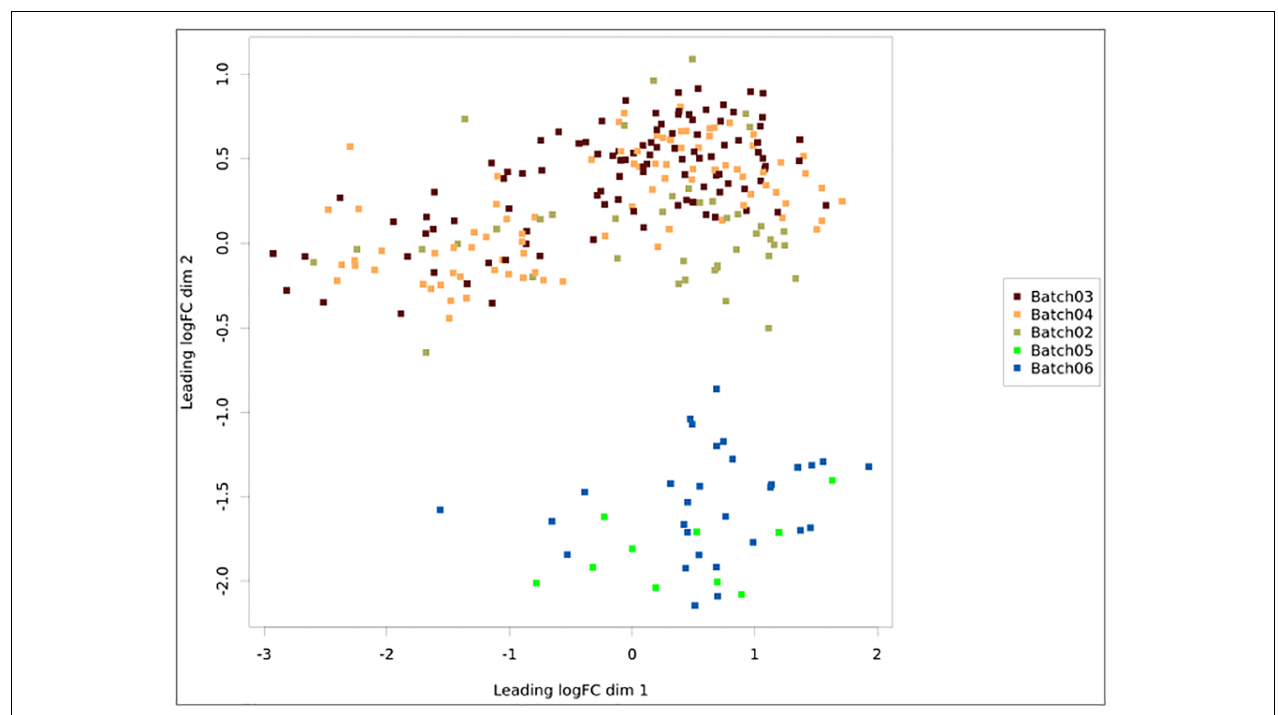
FIGURE 4 | Multidimensional scaling plot with the samples colored according to batch. The x - and y -axes represent the leading log-fold-changes between each pair of RNA samples, which is given by the root-mean-square of the largest absolute log-fold-changes between each pair of samples. In this example, there is a batch bias, whereas samples from batches 2, 3, and 4 are separated from 5 and 6.